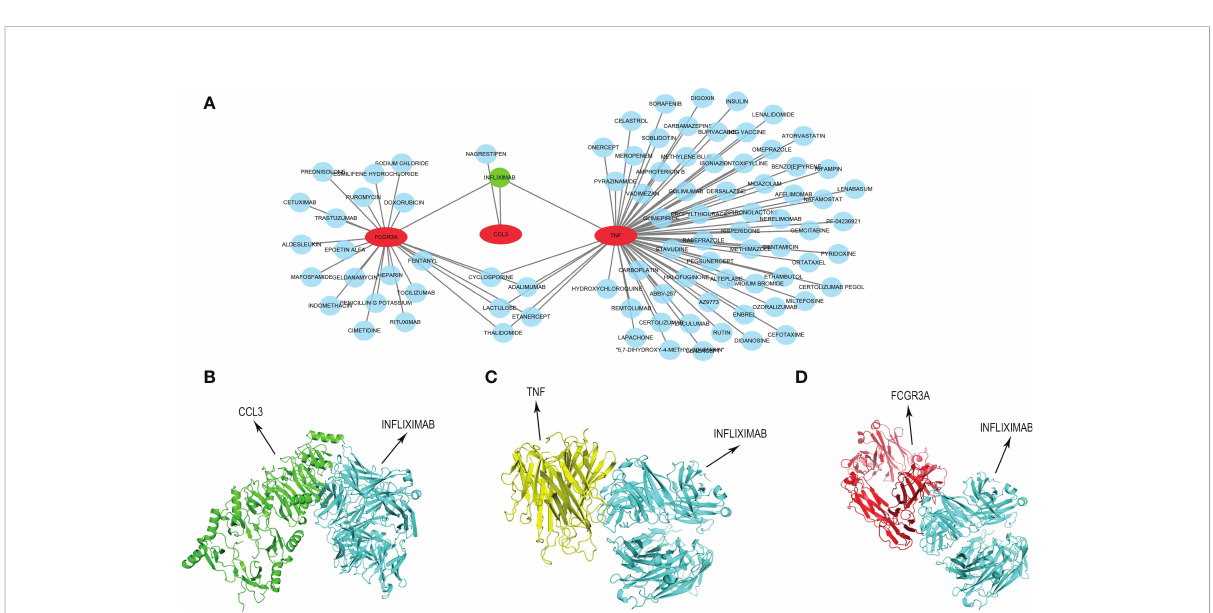
FIGURE 11 Construction of drug-gene interaction network. (A) The interaction between key genes and 87 potential drugs. (B) Protein-protein docking of CCL3 and INFLIXIMAB. (C) Protein-protein docking of TNF and INFLIXIMAB. (D) Protein-protein docking of FCGR3A and